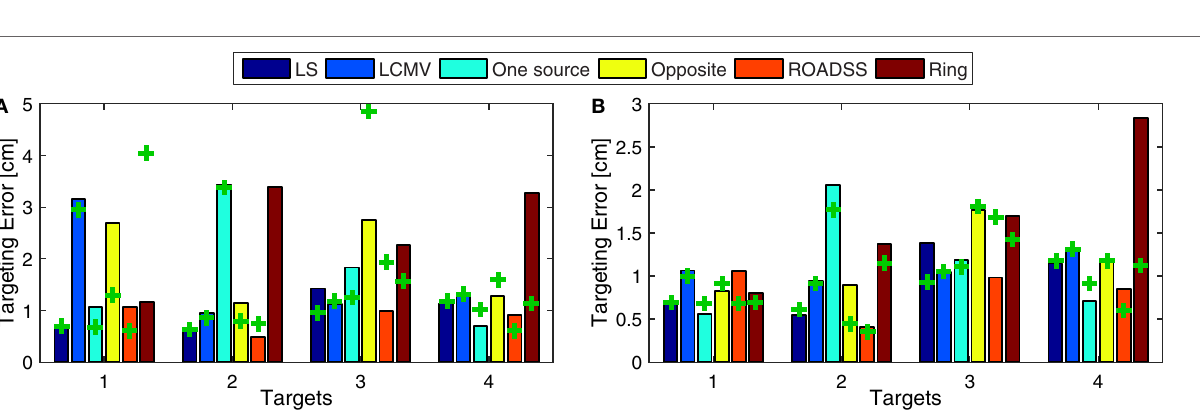
For each target and each method, we have computed the quan- titative metrics based on the total current density delivered to a target and its directionality, TE, and focality. The total current jections to the cortical normal vectors are shown in Figure 11B